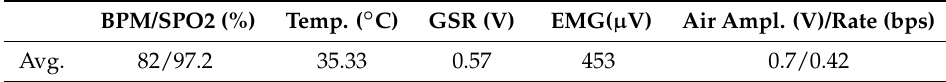
Table 2. Average values of measurements with different sensors (bps = breathes per